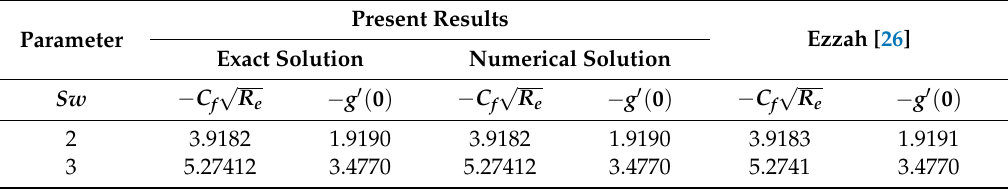
√ R x and − g (cid:48) ( 0 ) for several values of the suction parameter ( Sw ) at Table 2. Comparison of − C f